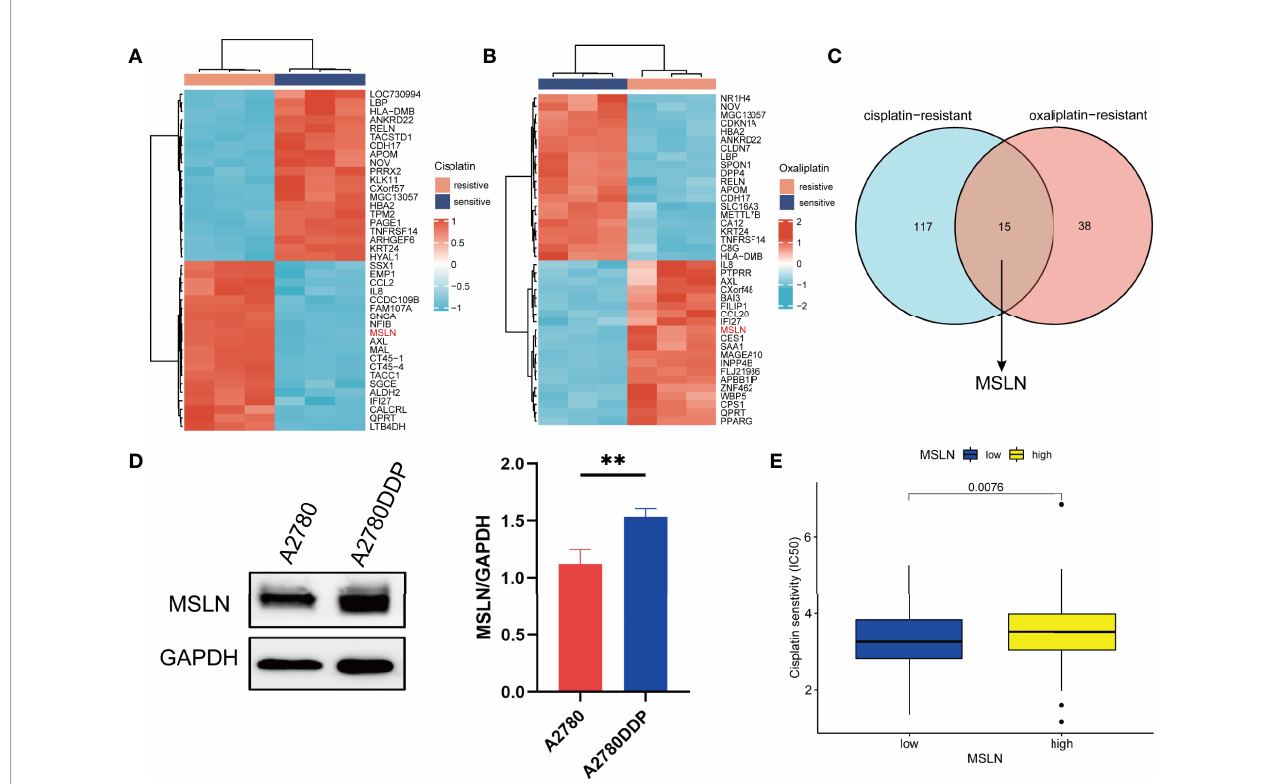
FIGURE 8 | MSLN is highly expressed in chemotherapy-resistant cell lines of ovarian cancer. (A, B) Heat maps of the top 50 differential genes in ovarian cancer cisplatin resistance/cisplatin sensitivity and oxaliplatin resistance/oxaliplatin sensitivity based on data from GEO database. (C) Venn diagram of differential genes for cisplatin resistance and oxaliplatin resistance. (D) Western blot shows the expression of MSLN in A2780 and A2780DDP and statistical analysis of gray value. (E) Effect of MSLN on cisplatin sensitivity (IC50) in ovarian cancer patients was assessed by Genomics of Drug Sensitivity in Cancer (GDSC). **, p <